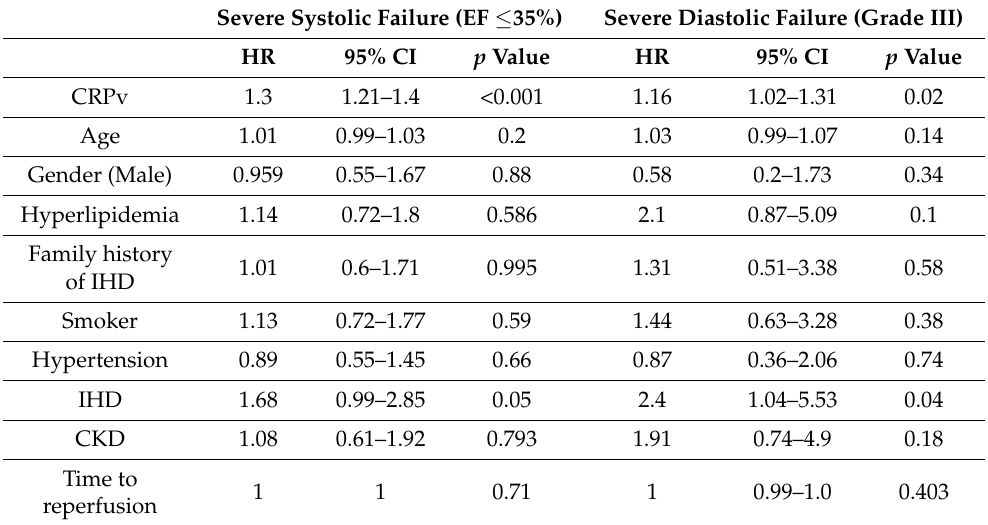
Table 3. Binary logistic regression analysis of predictors for severe systolic and diastolic heart